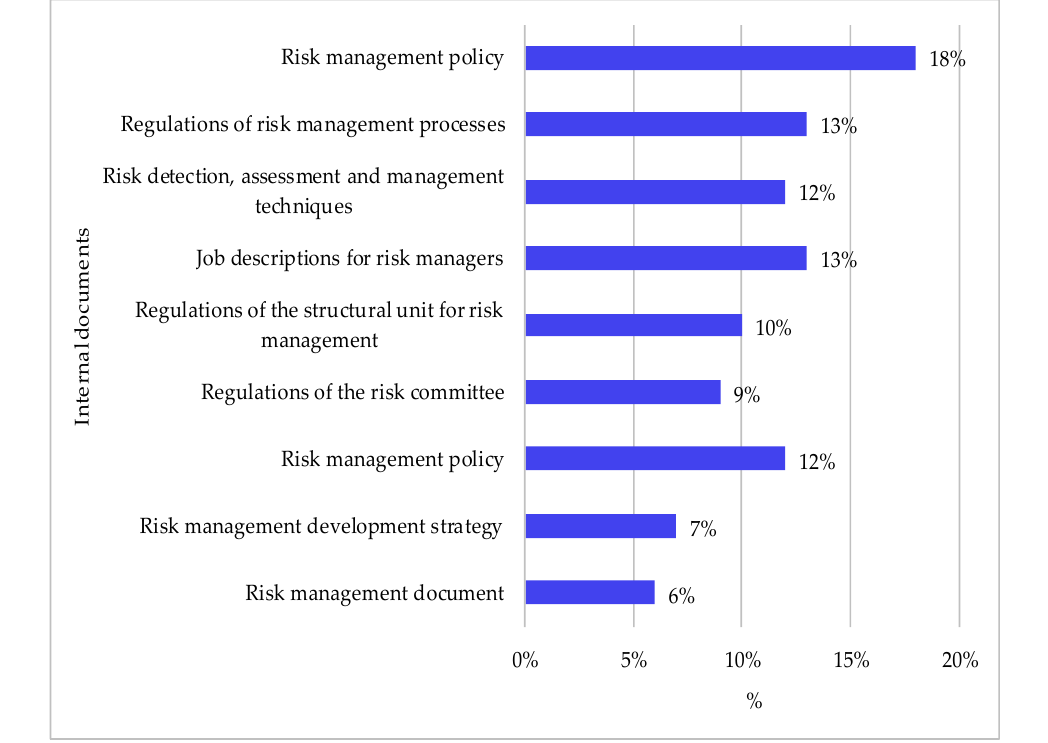
Figure 6. Risk management documents developed and introduced in 50 Polish companies. Source: authors’ study.